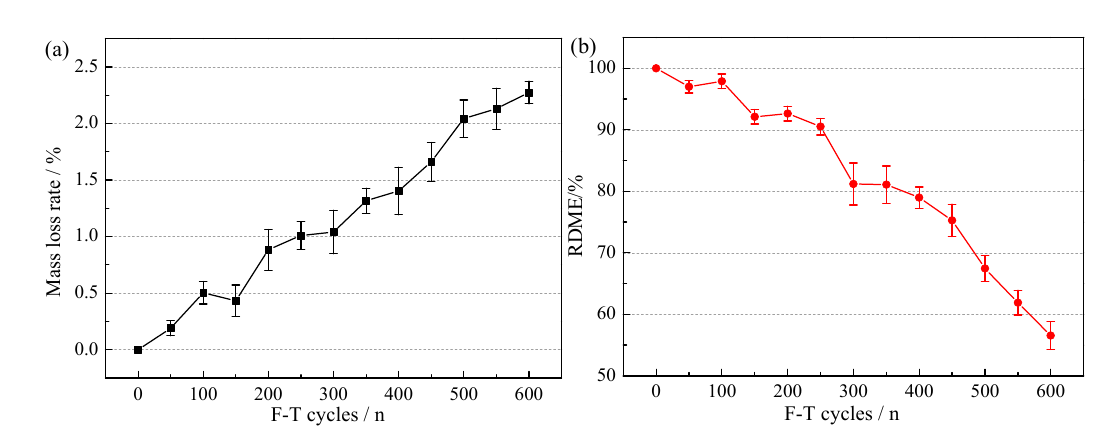
Figure 5. The variations of MLR ( a ) and RDME ( b ) of NAC after F-T cycles.